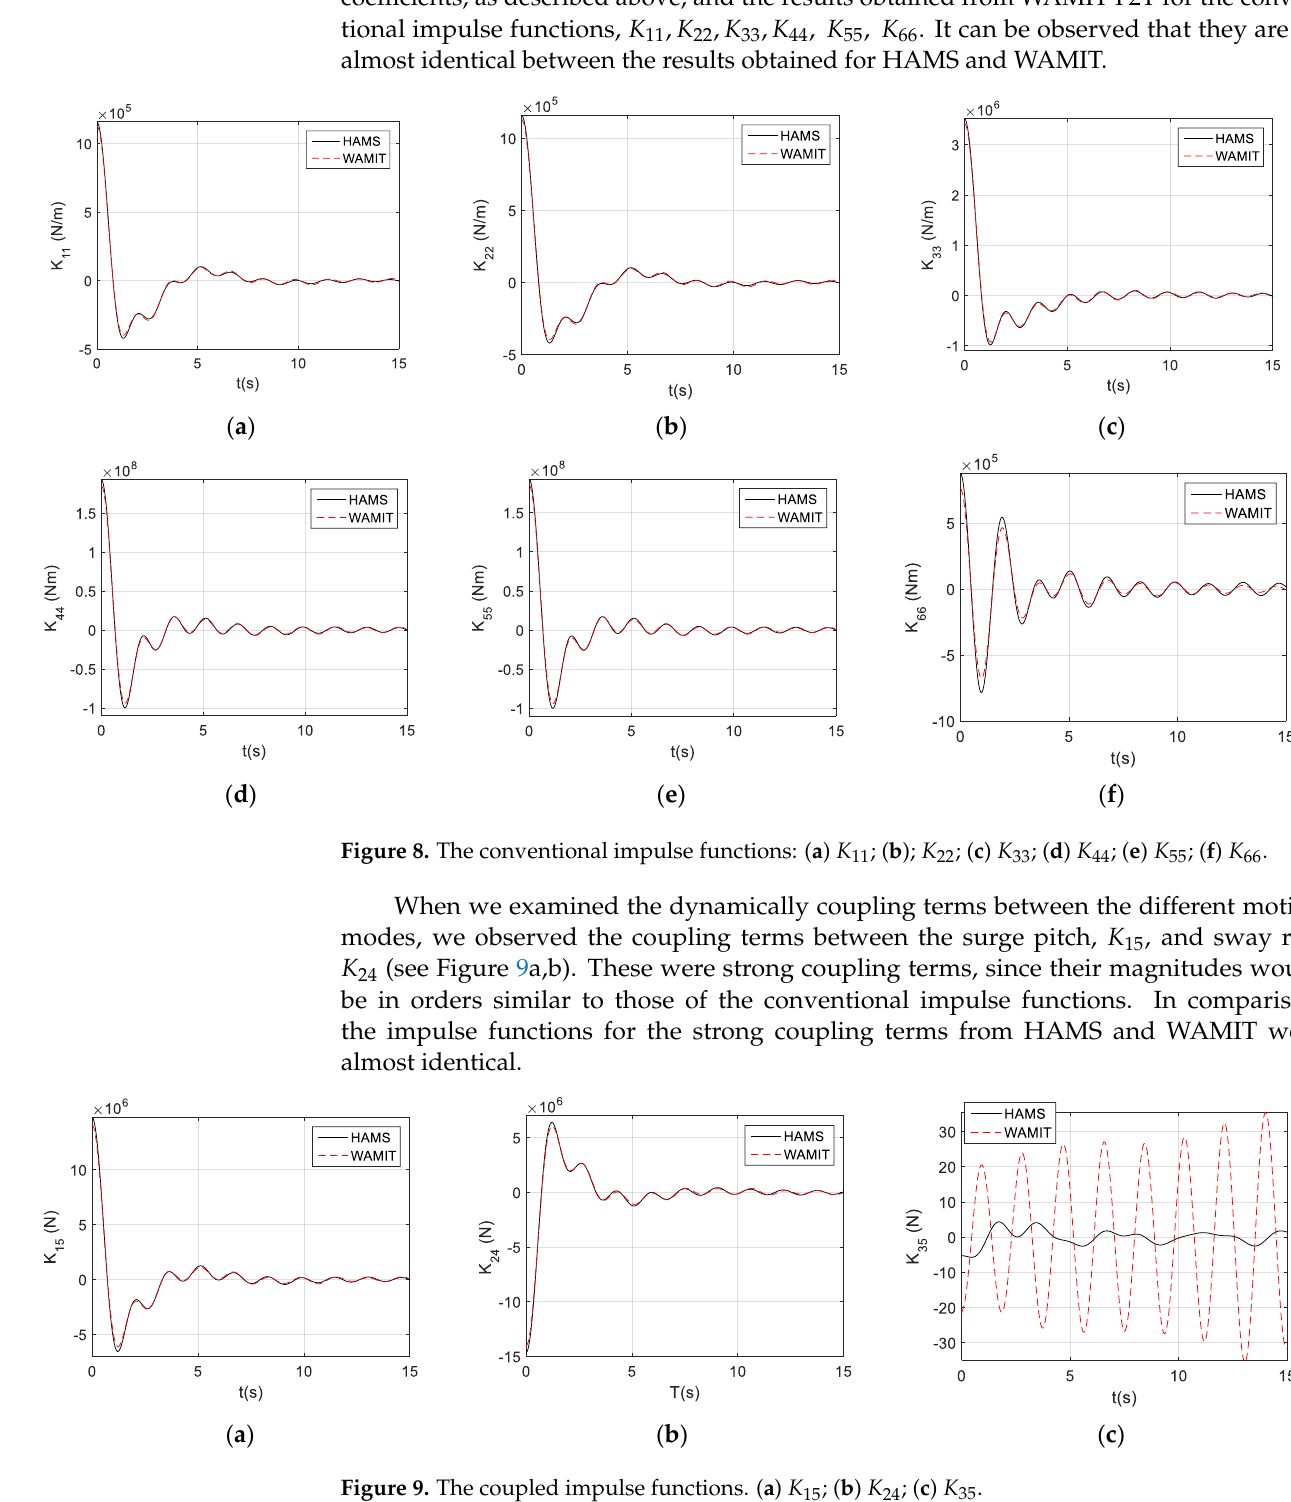
15 ; ( b ) K 24 ; ( c ) K 35